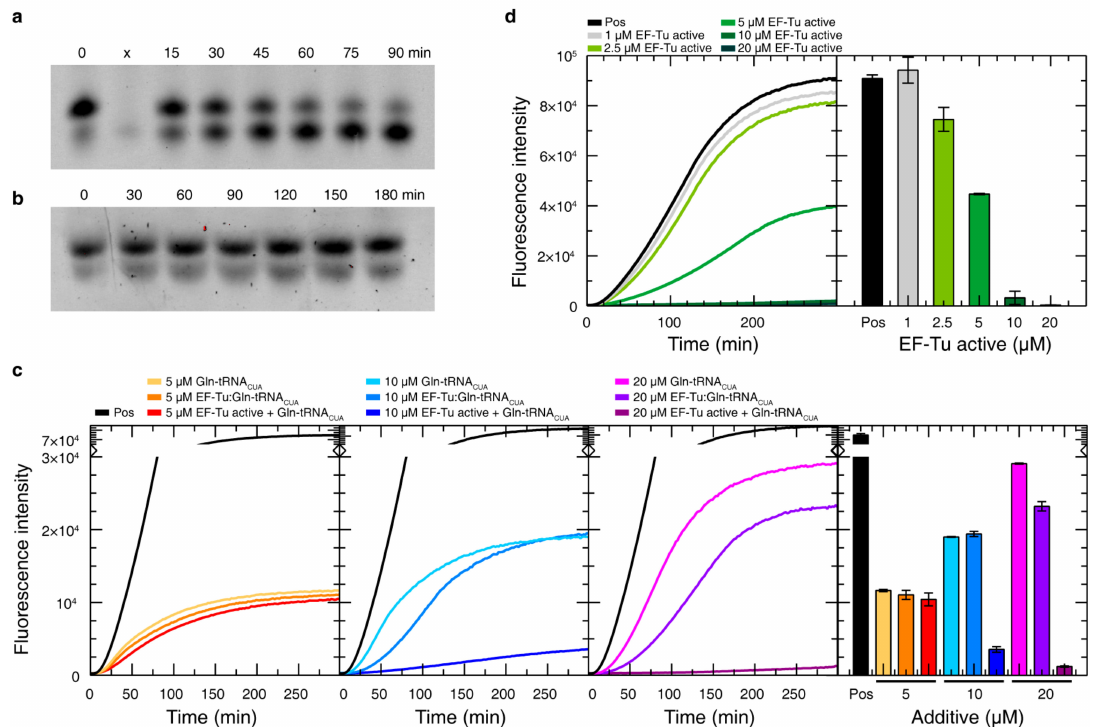
Figure 7. E ff ect of EF-Tu on Gln-tRNA CUA stability and CF HttEx1 synthesis. Deacylation assay of Gln-tRNA CUA in the absence ( a ) and in the presence ( b ) of a 2x excess active EF-Tu. ( c ) Time-resolved fluorescence and endpoint fluorescence for CF suppression reactions of H16 with a stop codon at position Q20 when titrating with increasing concentrations of Gln-tRNA CUA alone, a